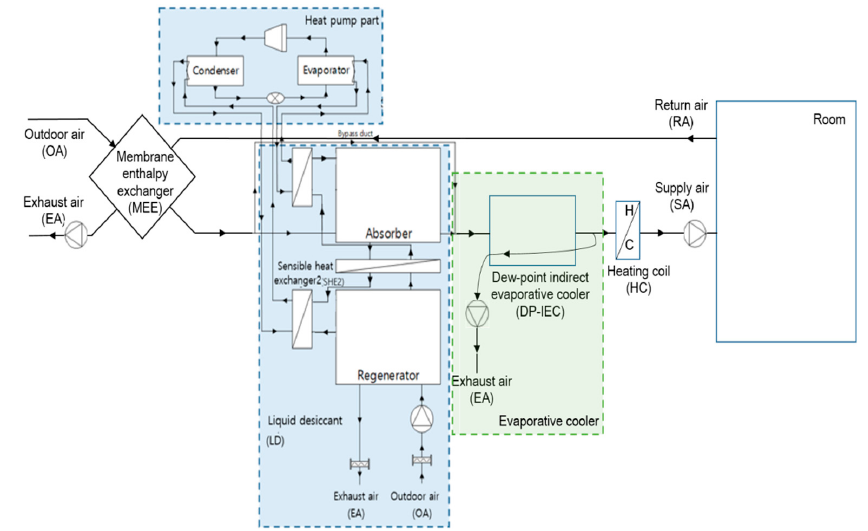
Figure 4. Liquid desiccant and dew-point evaporative-cooler-assisted 100% outdoor air system